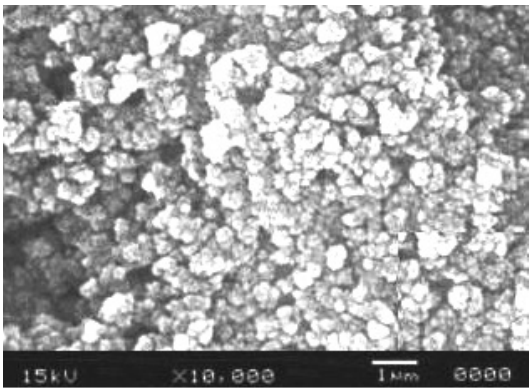
Fig.2 SEM image of the TiO